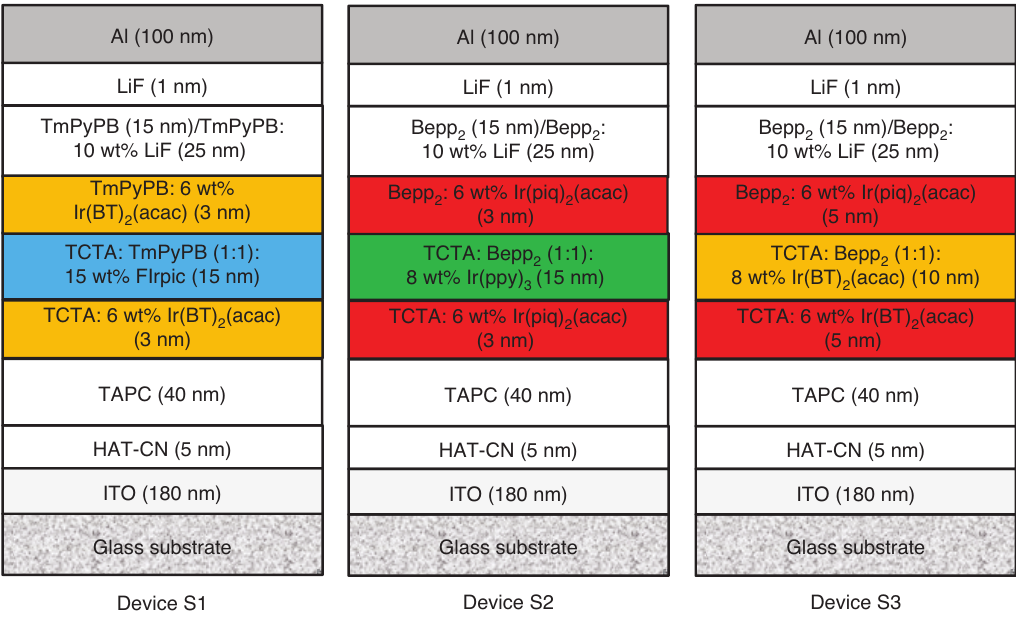
Figure 4: The device structure diagrams of symmetrical EMLs single unit WOLEDs